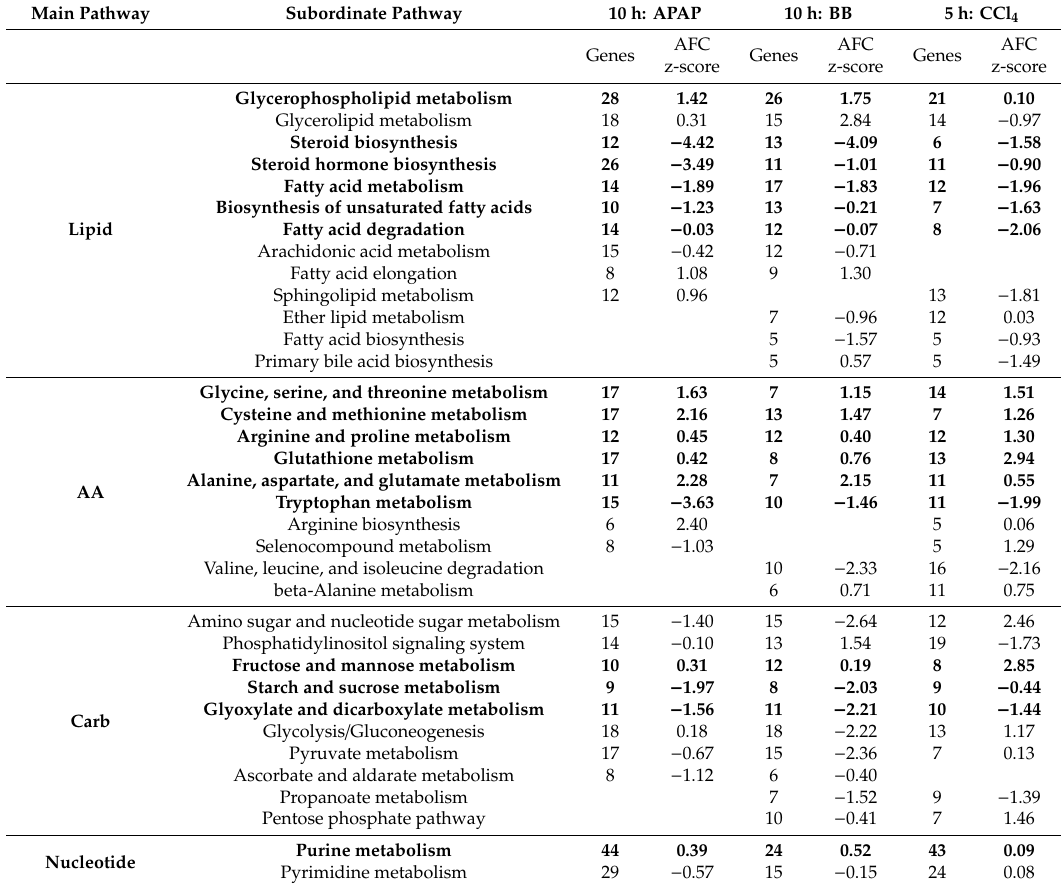
Table 1. Summary of the significantly altered common metabolic pathways identified using gene- enrichment analysis at the peak response. Values in bold represent pathways that were consistently up- or down-regulated across all three toxicants. Positive and negative aggregated fold change (AFC) z-scores indicate pathways that are up- and down-regulated, respectively. AA: Amino acid; Carb: Carbohydrate. Main